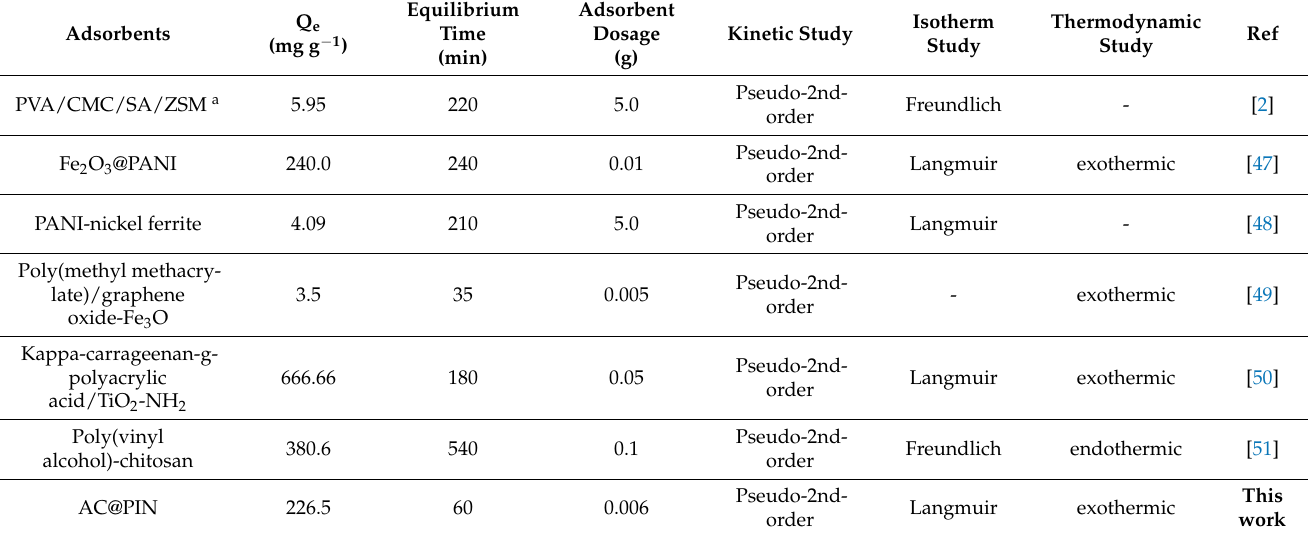
Table 4. Comparison of adsorption properties of various polymer based adsorbents towards Mala- chite Green